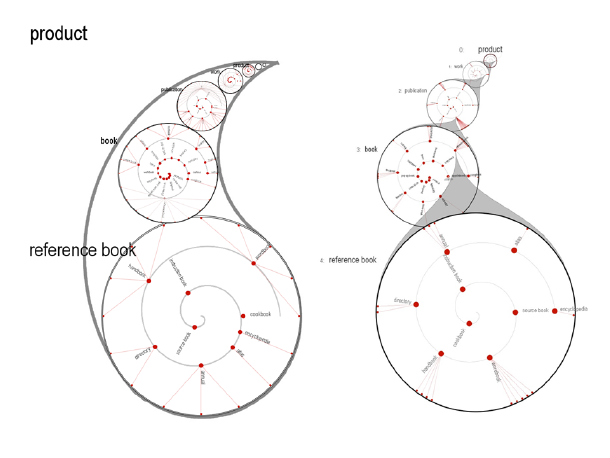
Figure 5. Left: PaisleyTree with the paisley outline. Right: PaisleyTree without the paisley outline. are placed on the perimeter of the node circle (this region is highlighted with green) using node- link layout. To reduce cluttering, the children are divided into two groups, leaf children and non-leaf children. Leaf children are placed on the spiral’s inner ring (highlighted with blue), non-leaf children on the outer (highlighted with red). The children